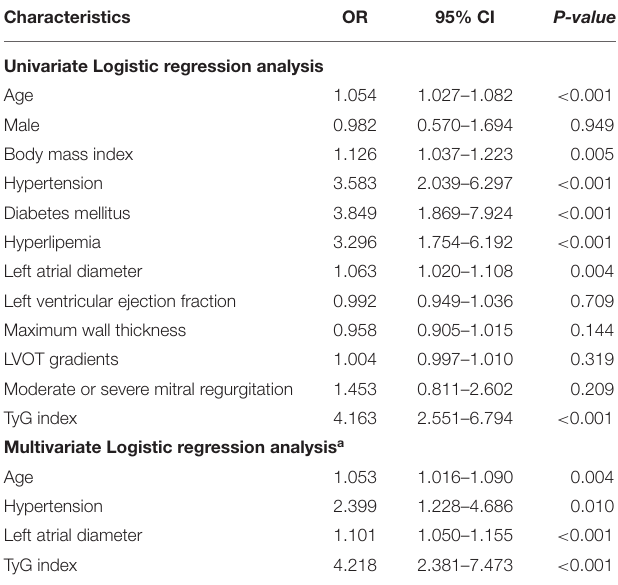
TABLE 3 | Logistic analysis for predictors of postoperative atrial